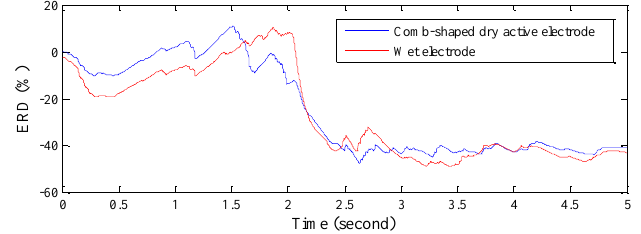
Figure 7. Comparison of ERD quantifications recorded at C3 by using retractable comb-shape dry active electrodes and wet electrodes for right hand motor imagery.